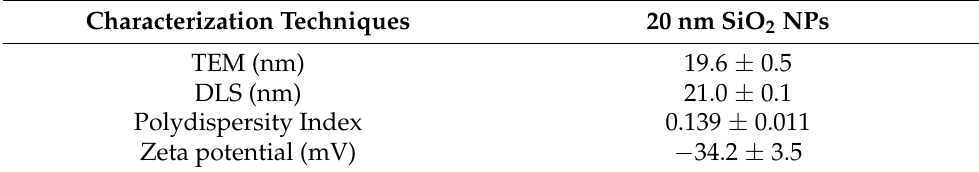
Figure 1. ( A ) Transmission electron microscopic image and ( B ) FT-IR spectrum of 20 nm SiO 2 NPs before culturing with HepG2 cells. Table 1. Characterization of SiO 2 NPs (Mean ± SD, n =